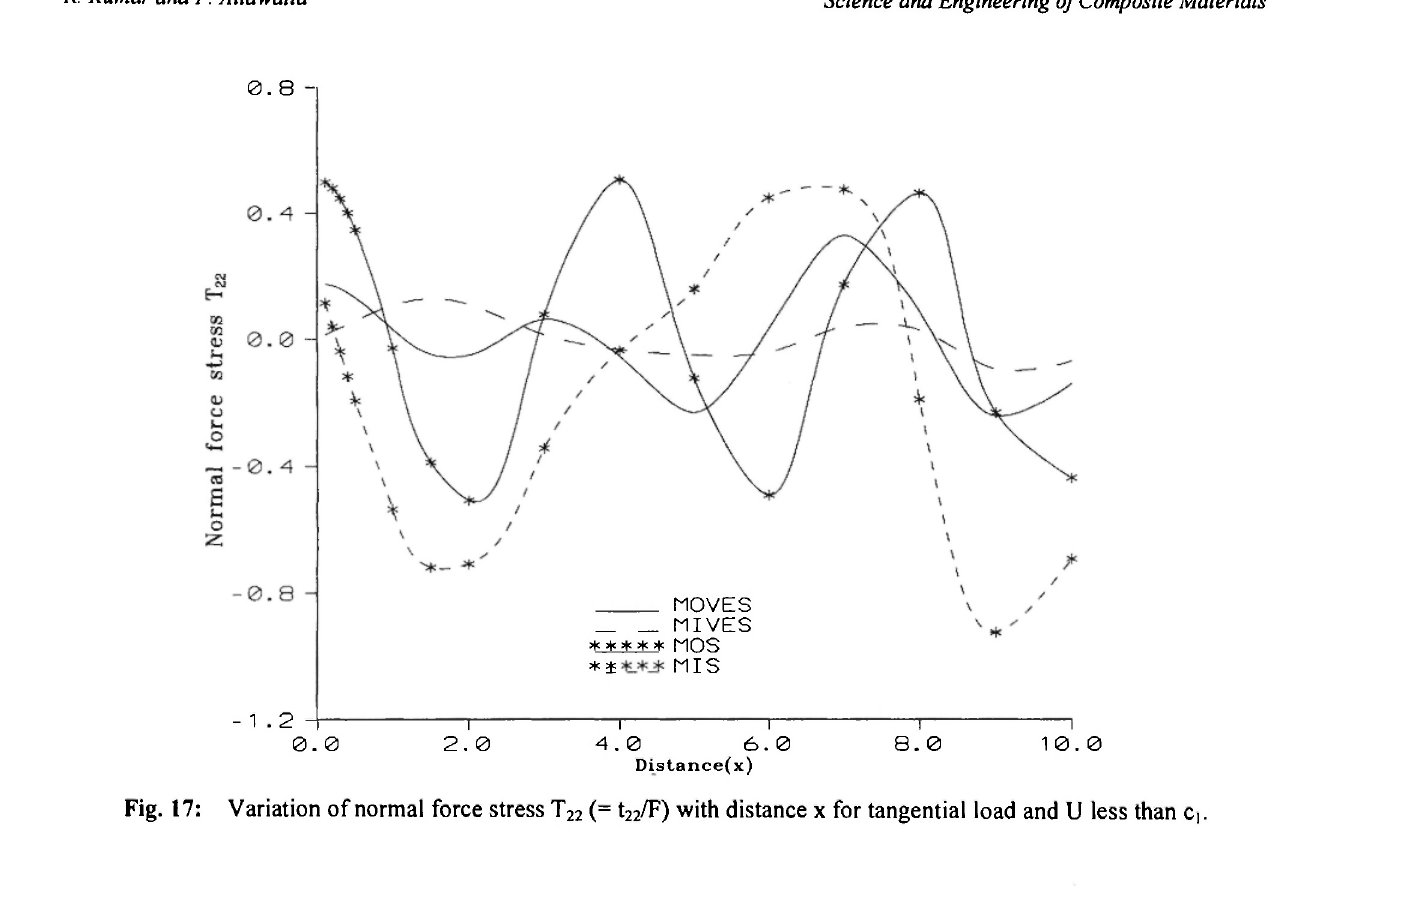
Variation of normal force stress T 22 (= t 22 /F) with distance χ for tangential load and U less than c,.